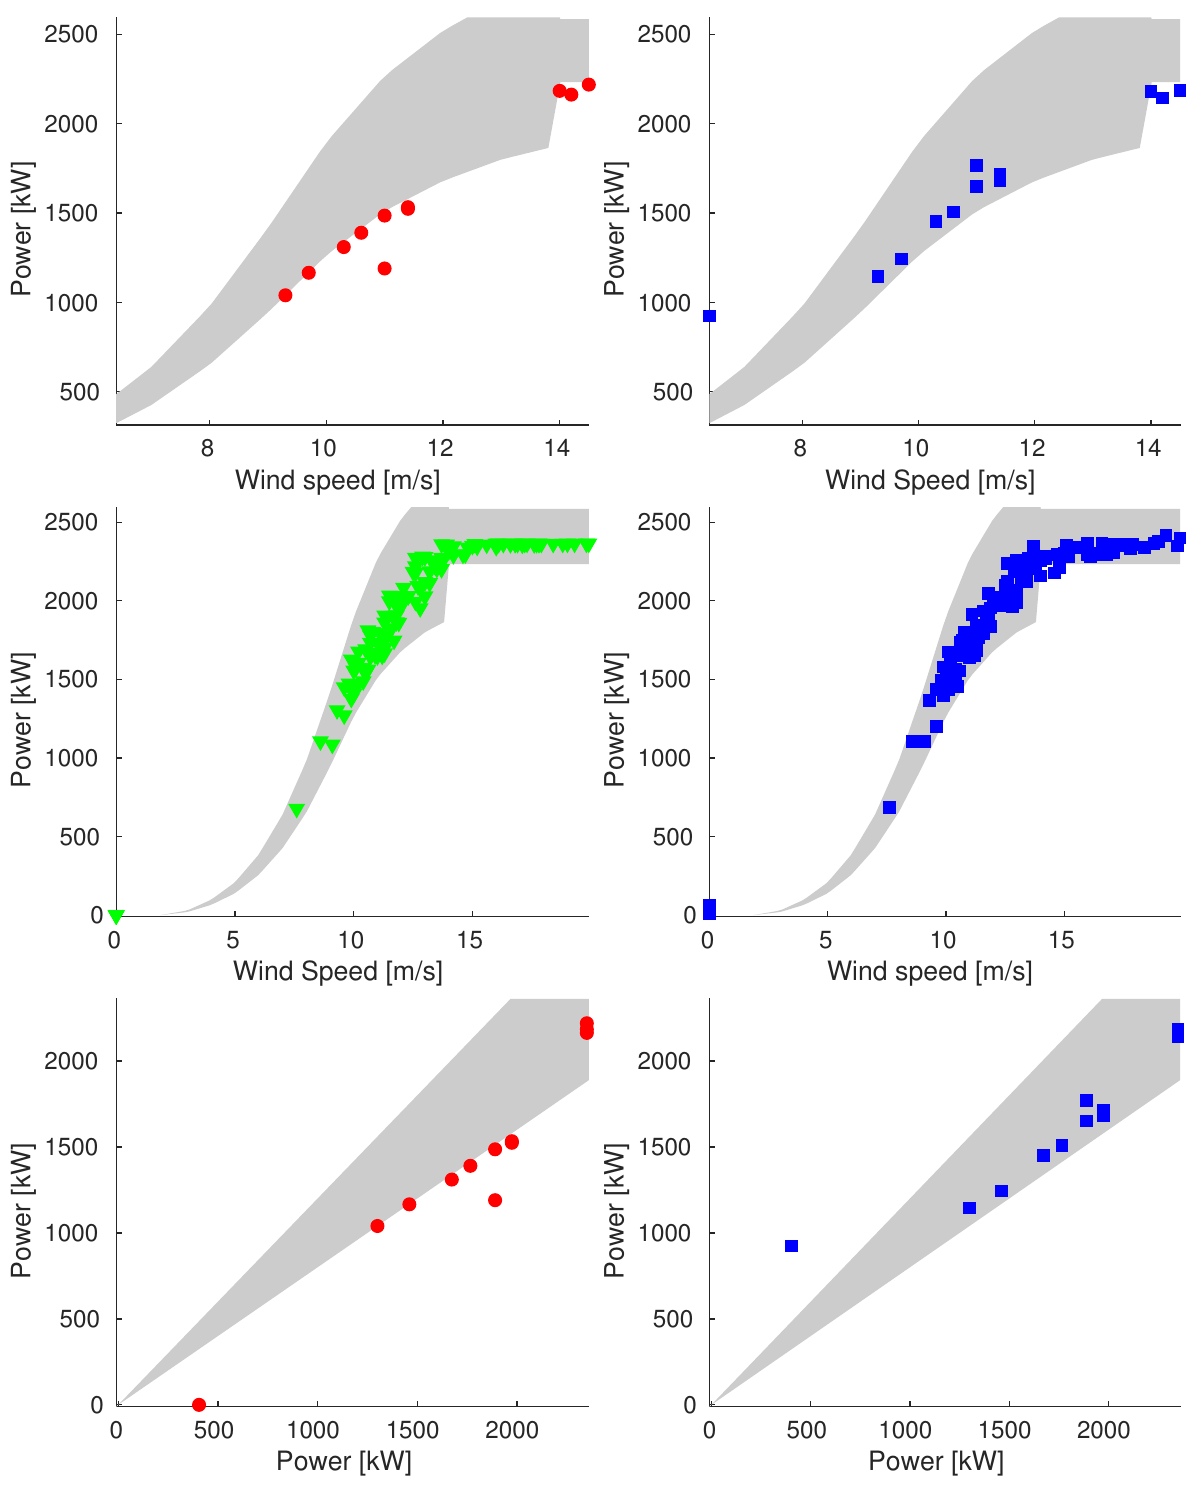
Figure A10. Plot of reconstructions for data points of 2 June ( Sample_100 ). We compare original data (on the left ) and reconstructed values (on the right ). We show plots of power vs.wind speed of rejected and validation data ( up and middle respectively) and plot of power vs.ideal power of rejected data ( bottom